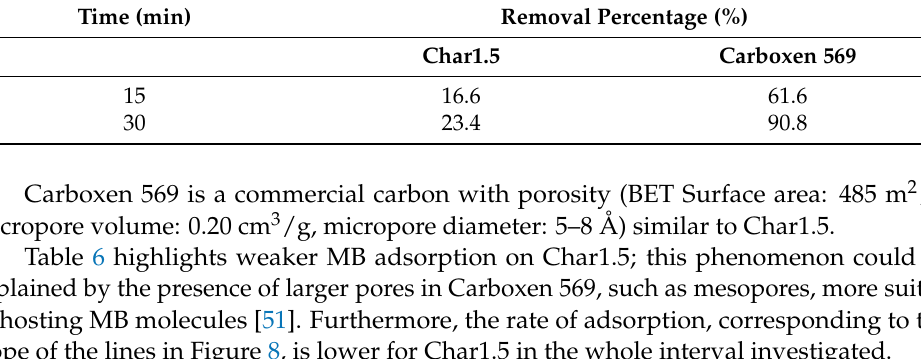
514 nm, and 442 nm), are illustrated in Figure 7.